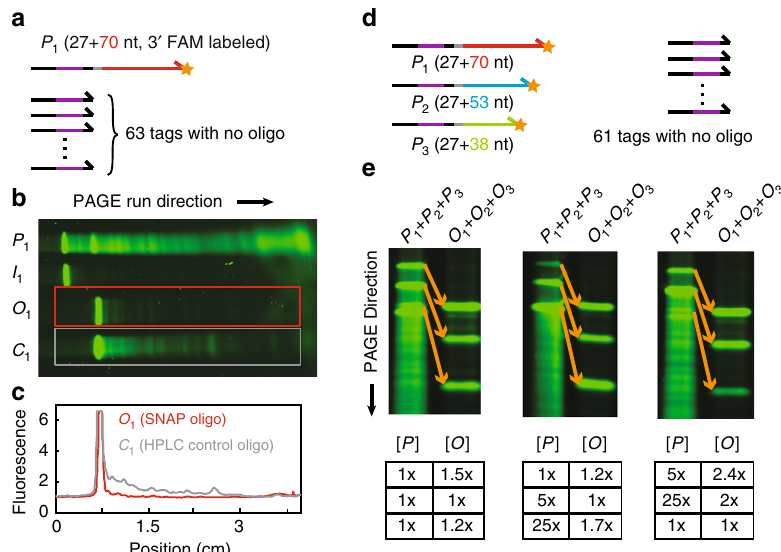
Fig. 2 Fluorescence polyacrylamide gel electrophoresis (PAGE) analysis of SNOP products. a Precursors for analysis of SNOP product purity. One precursor that produces the oligo product of interest is synthesized with a 3 ′ FAM fl uorophore label. Here, the randomer region has length B = 6, and the 63 other precursors contain only the tag sequence and does not produce an oligo product. This experiment thus shows the purity of a typical 64-plex SNOP product. b Fluorescent PAGE of the precursor P 1 , the intermediate I 1 in which the tag is not cleaved, the oligo product O 1 , and a control oligo C 1 ordered commercially